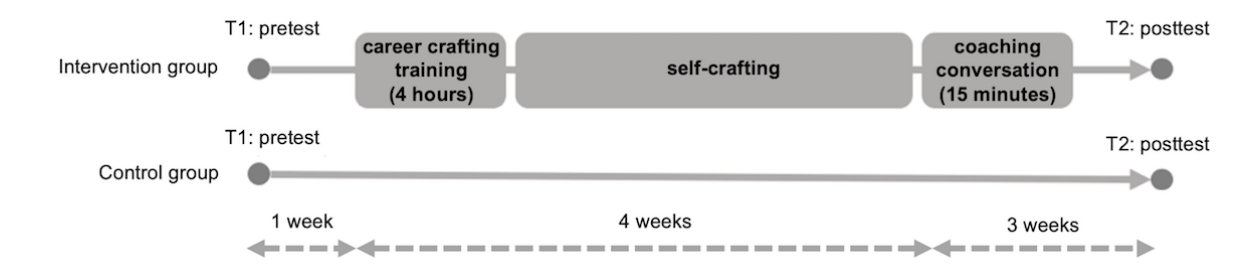
Figure 1. Design of the career crafting